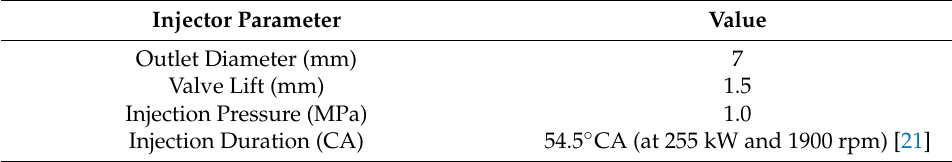
Table 1. Specifications of NG injector.